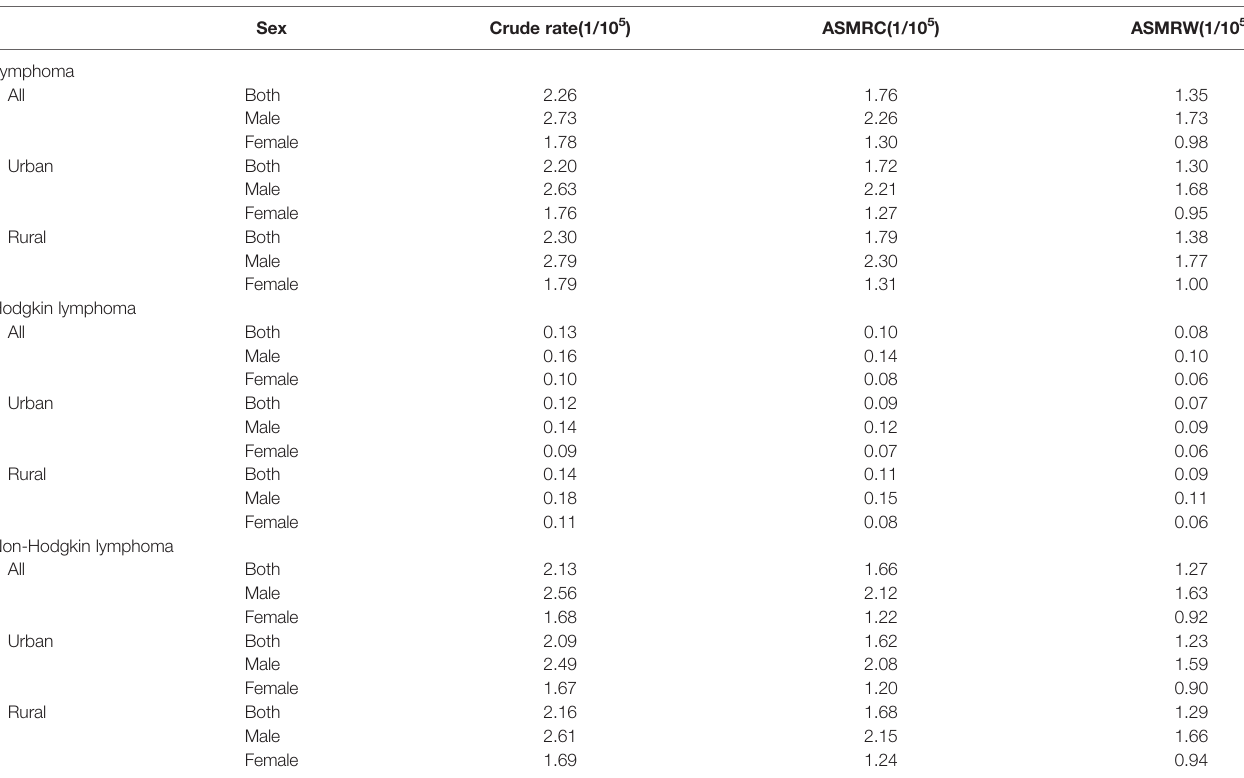
TABLE 1 | Mortality rate of lymphoma by sex and residence in China,